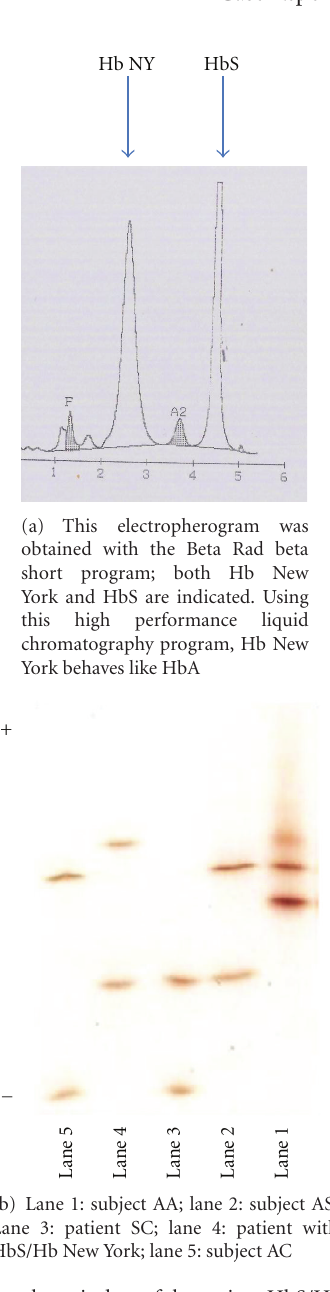
protein and an unknown protein (Figure 2(b)).